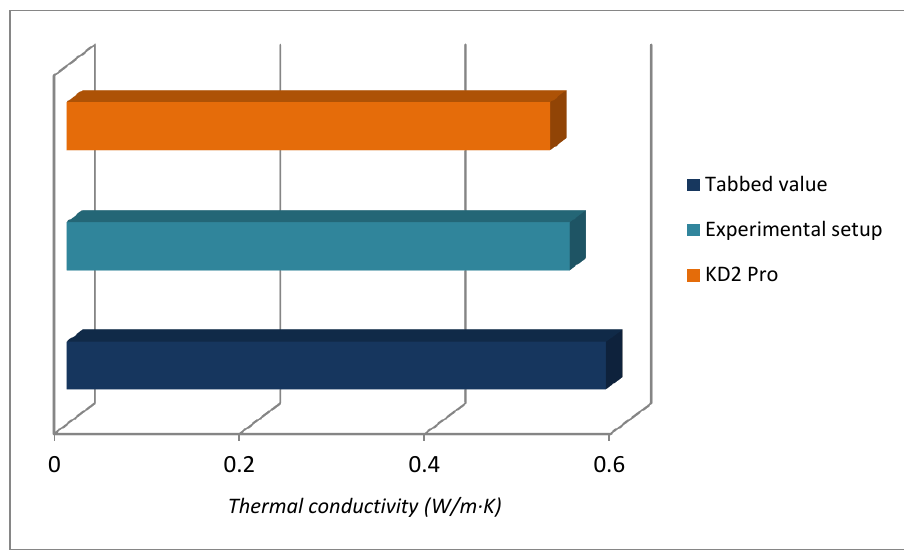
Figure 14. Thermal conductivity of the sandy material obtained from the experimental setup, the KD2 Pro device, and the standard tabulated value.